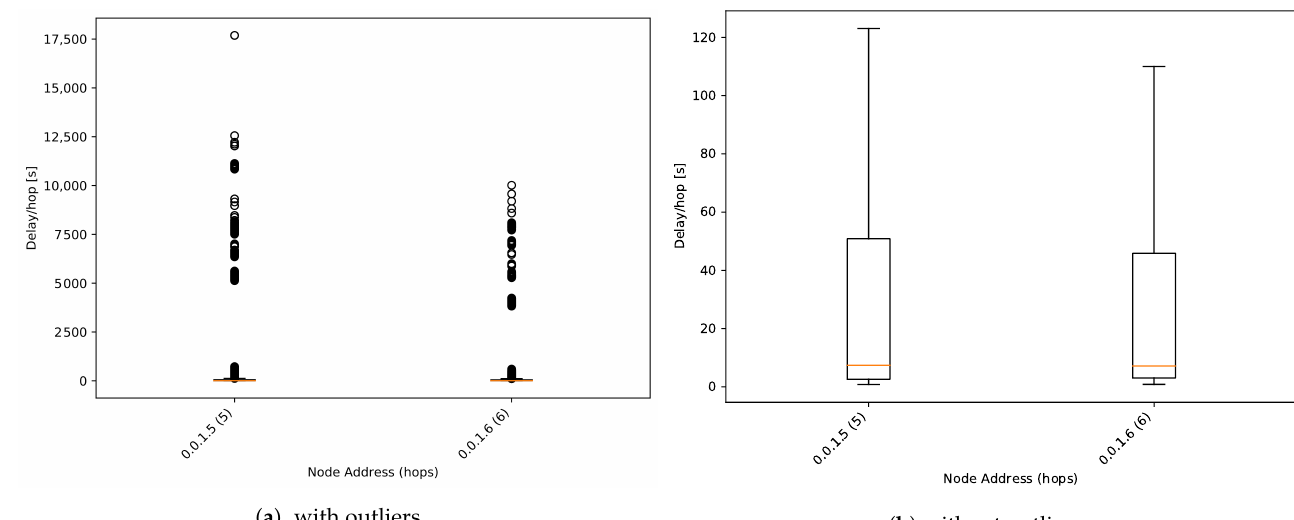
Figure 14. One-way delay boxplot for alarm